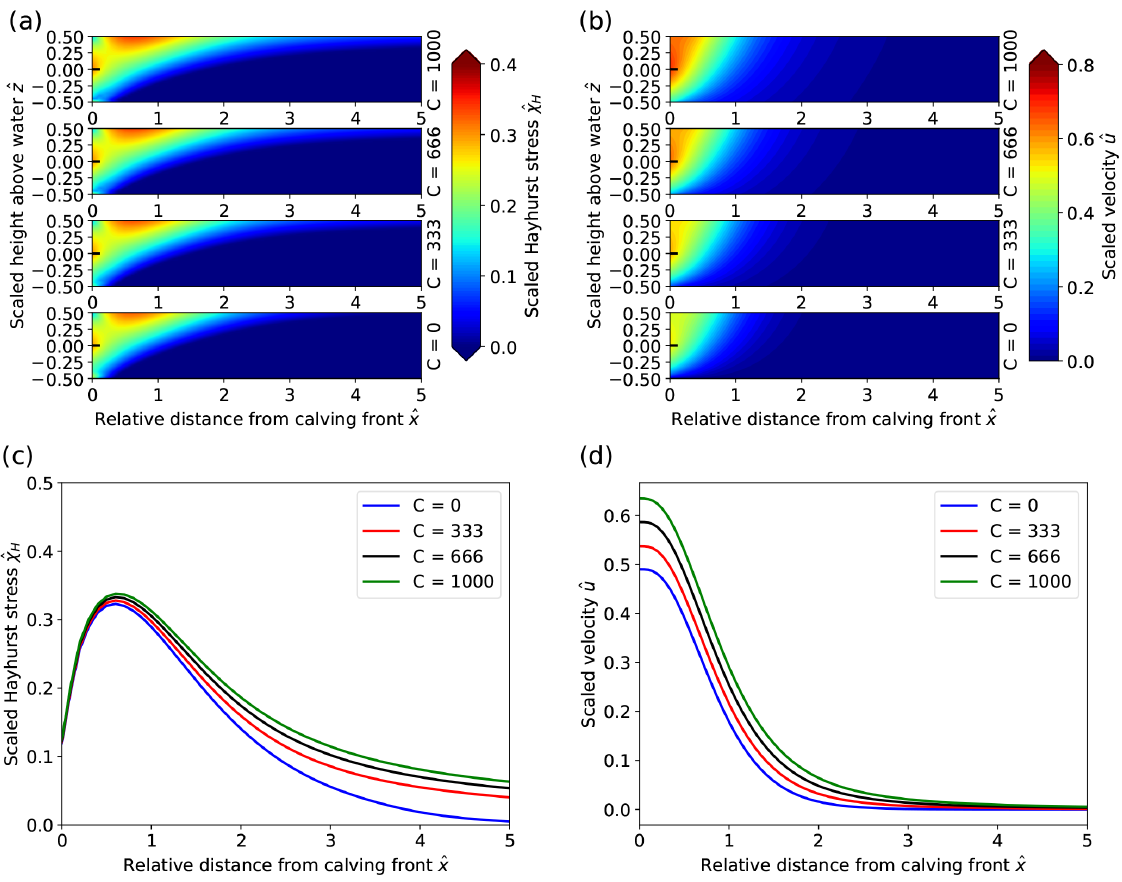
Figure 6. Sensitivity experiment results for varying bed slipperiness C . Panels (a–d) are the same as Fig. 3. In panels (a, b) , the subplots show increasing bed slipperiness from the bottom to the top. Units for bed slipperiness C are mMPaa − 1 .